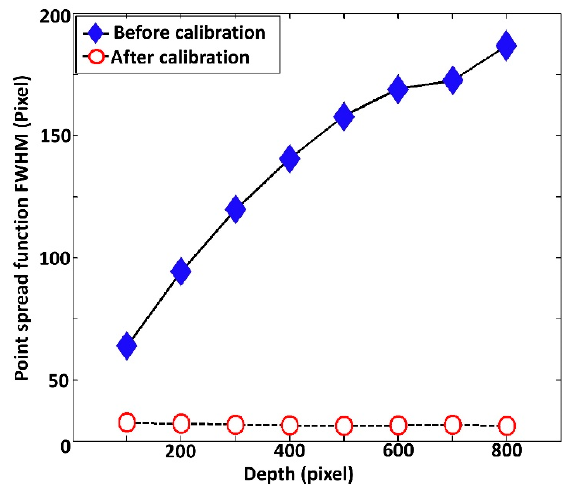
Figure 6. Full width at half maximum (FWHM) comparison between before (without) and after (with) spectral calibrated depth-dependent